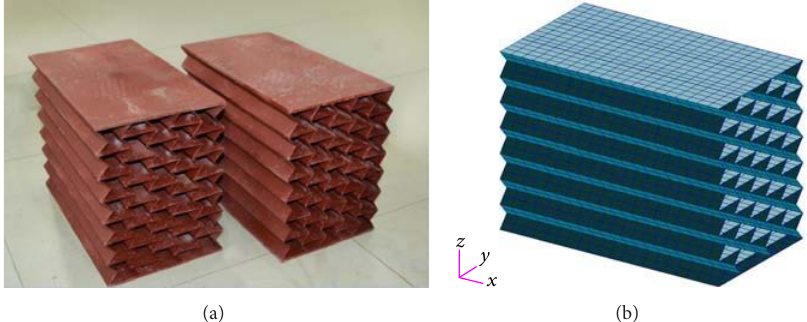
Figure 1: Auxetic cellular vibration isolation base: (a) photo and (b) the FE model.